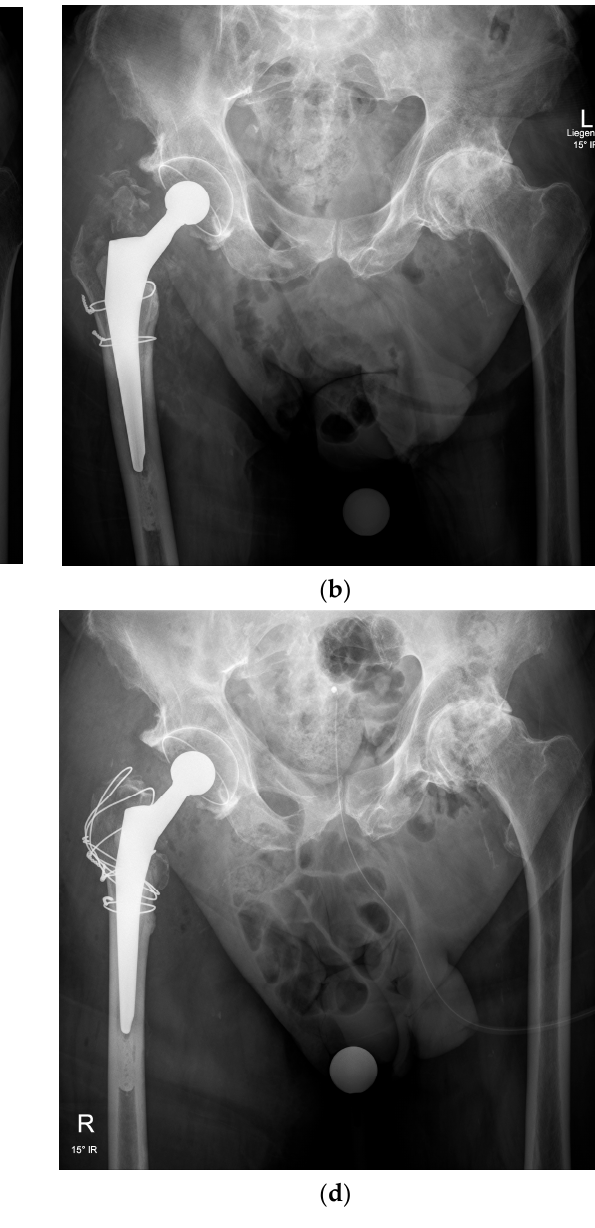
Figure 3. Anteroposterior pelvic radiographs of an intertrochanteric fracture with advanced osteoarthritis ( a ) treated by total hip arthroplasty with a cemented femoral stem, a cemented acetabular cup, and two wire cerclages to stabilize the metaphyseal fragments around the femoral stem but without fixation of the greater trochanter ( b ), resulting in recurrent dislocations in the early postoperative period ( c ) and requiring revision surgery for fixation of the greater trochanter by a figure-of-eight wire cerclage technique allowing restoration of hip stability and healing of the fracture fragments in a good position with no further dislocation ( d ).